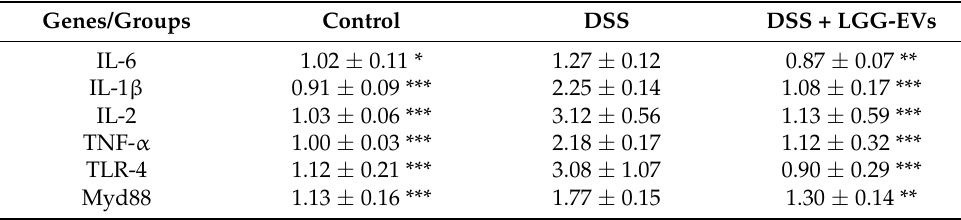
Table 3. LGG-EVs inhibited DSS-induced the up-regulation of related inflammatory genes.